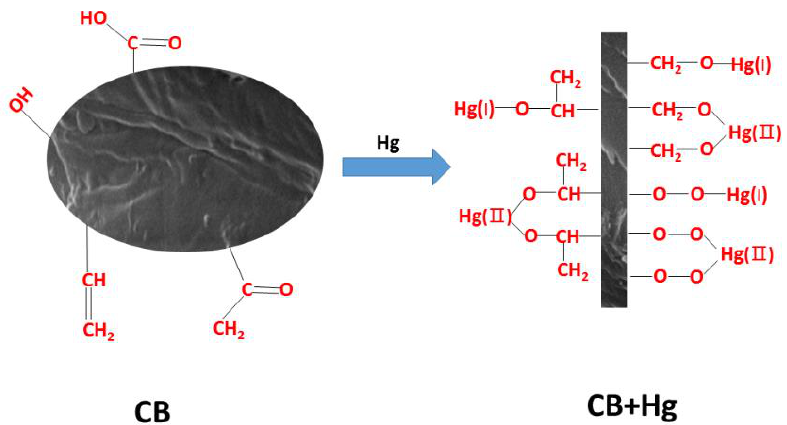
Figure 6. Schematic illustration of the possible Hg adsorption mechanism of the CB.